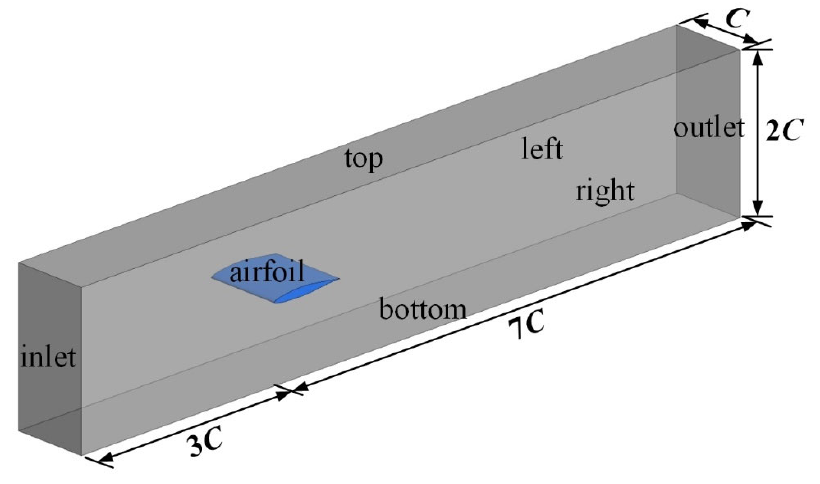
Figure 1. Computational domain.